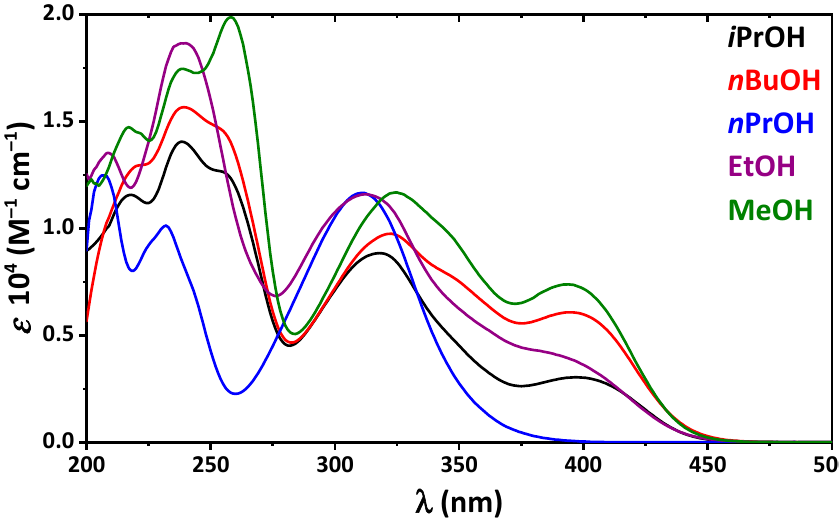
Figure 2. UV-vis spectra of 4 in the applied solvents.